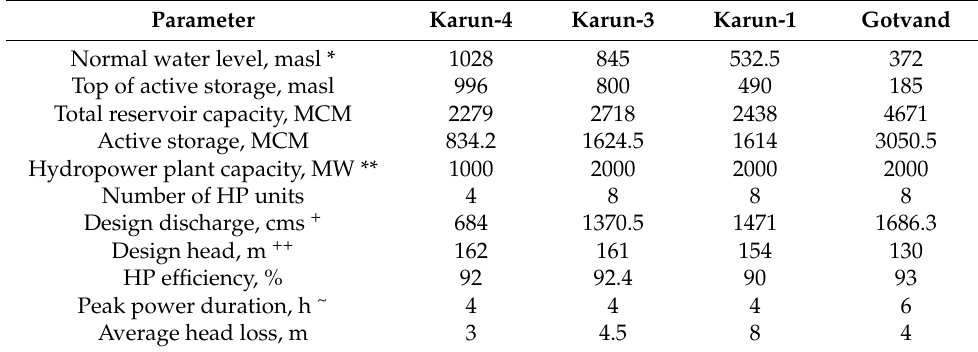
Table 1. Specifications of reservoirs and power plants.